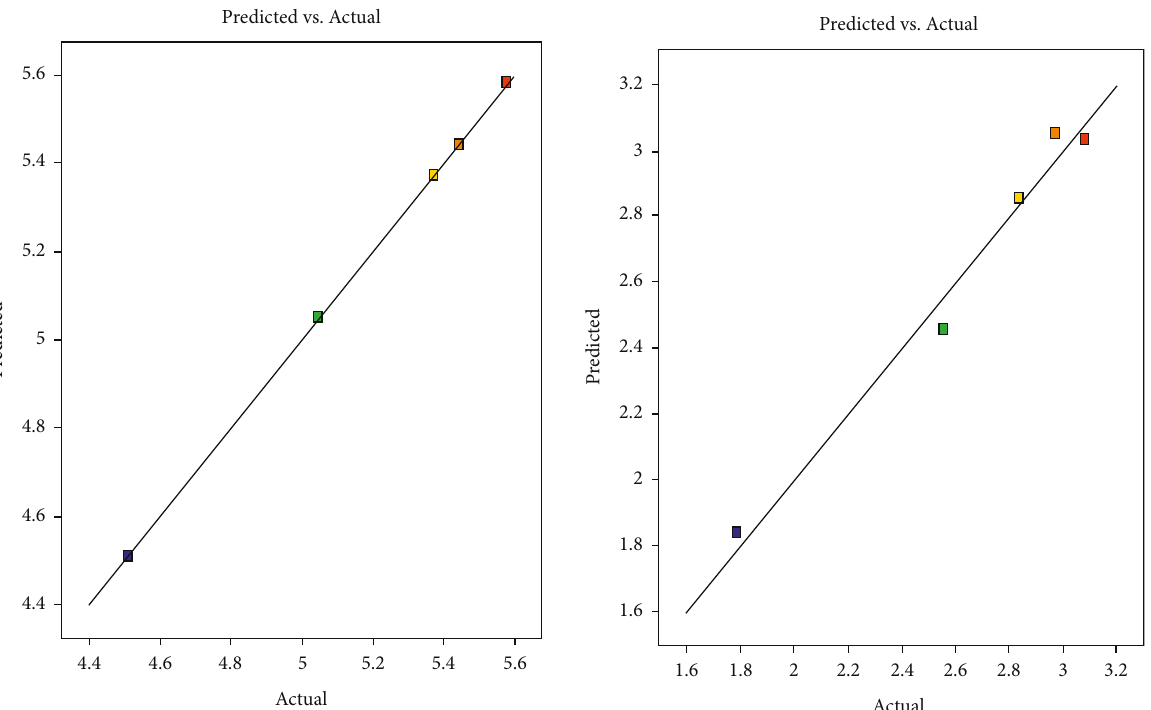
Figure 11: Predicted vs. actual diagnostic